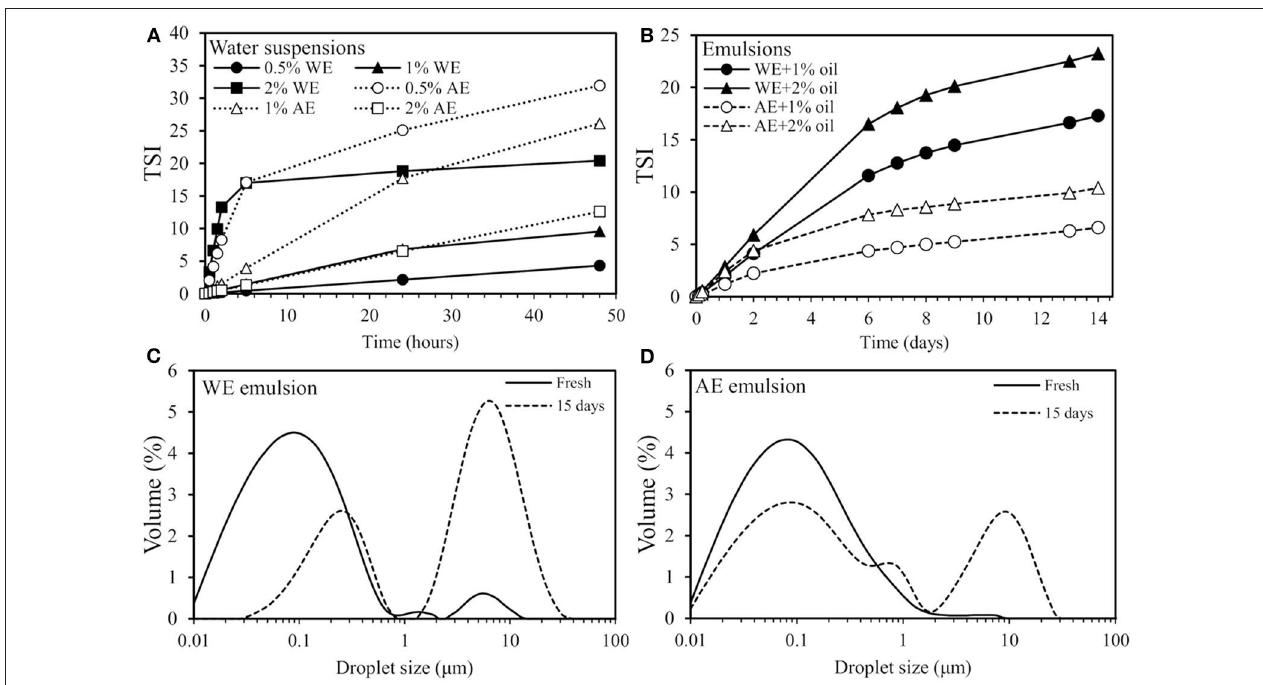
FIGURE 5 | (A) Turbiscan stability index (TSI) of water suspensions prepared with 0.5, 1, and 2% (w/w) of water extract (WE) and alkaline extract (AE), (B) TSI of emulsions prepared with 1% (w/w) WE and AE and with 1 and 2% oil content, (C,D) Droplet size distributions of emulsions as fresh (–) and after 15 days of storage (- - -) prepared with 1% (w/w) WE or AE and 1% oil.